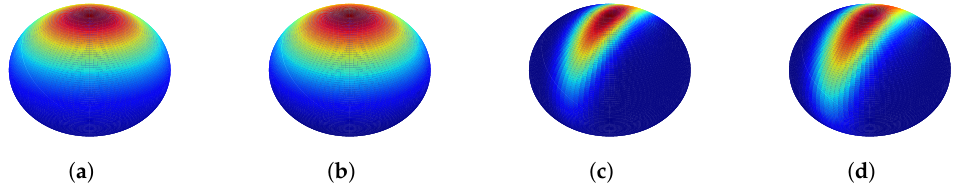
Figure 1. The two leftmost plots visualize the transition densities of ( a ) a Fisher–Bingham–Kent distribution and ( b ) the pushforward density of a Brownian motion to S 2 with a bi-invariant metric. The pushforward measure of a Brownian motion on SO ( 3 ) to the sphere S 2 results in anisotropic distributions on S 2 when the metric on SO ( 3 ) is not bi-invariant, for ( c ) T = 0.5 and ( d ) T = 1.0. The coloring indicates the density of the pushforward (different color scheme for each